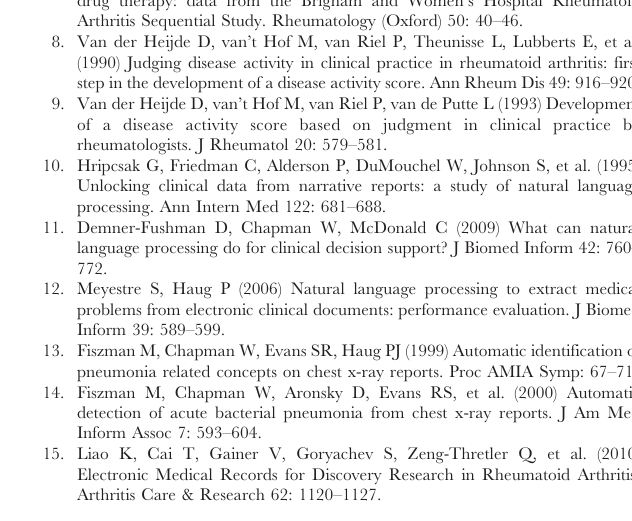
Table S1 Number of features for a user-defined customized dictionary, Unified Medical Language System Concept Unique Identifier (UMLS CUI), Word, and Word_CUI bigram on the Training Set. Table S2 Portability test for all classifiers trained on Unified Medical Language System Concept Unique Identifier (UMLS CUI) features: using lab feature vs. no lab features. Table S3 Portability test for all classifiers trained on user-defined customized dictionary features: using lab feature vs. no lab features. Table S4 Portability test for all classifiers trained on word features: using lab feature vs. no lab features. Table S5 Portability test for all classifiers trained on word-CUI bigram features: using lab feature vs. no lab features. Table S6 Table of